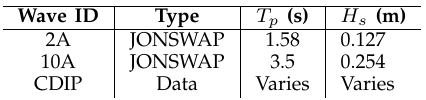
TABLE I: Model-scale wave ID